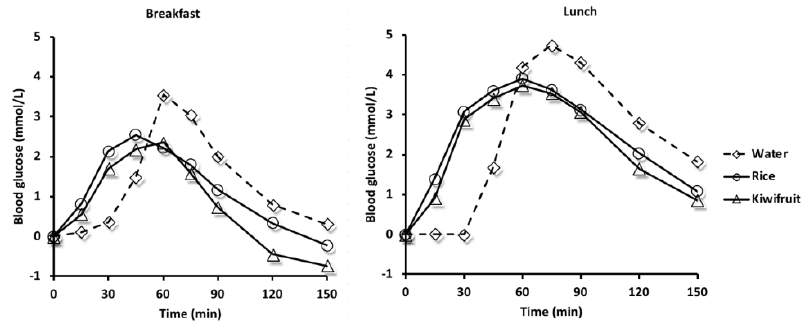
Figure 3. Mean incremental change in blood glucose concentrations at breakfast ( n = 28) and at lunch